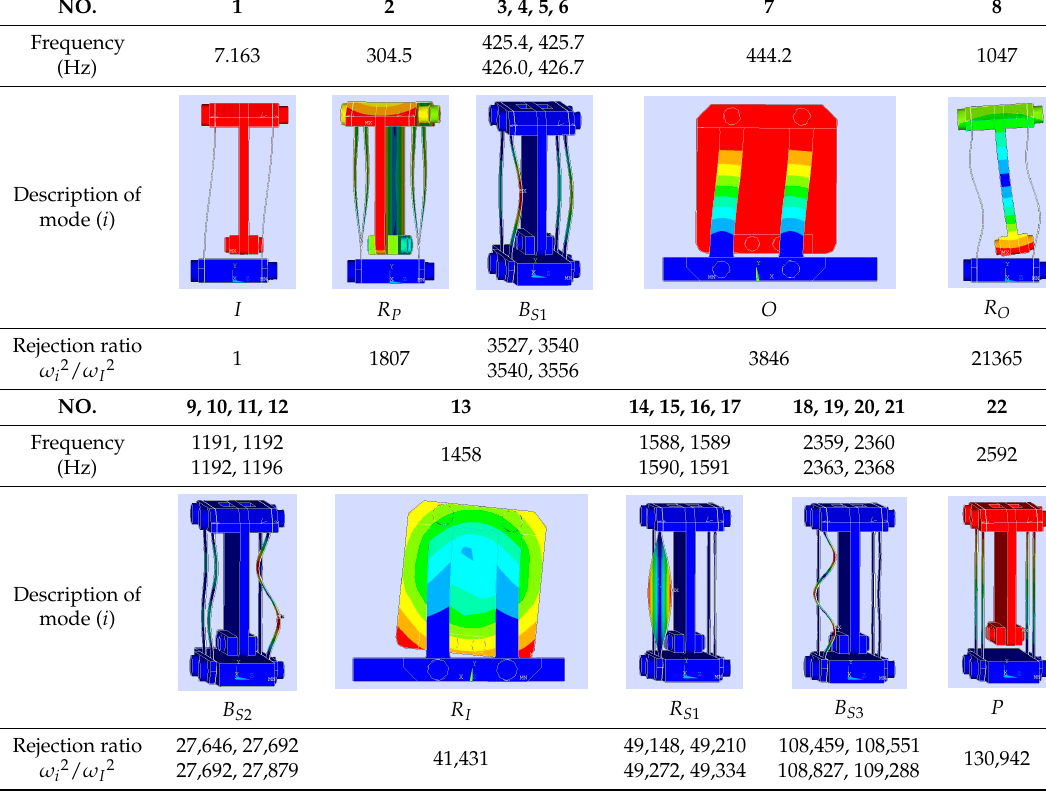
Table 2. The 22 lowest oscillation modes of the proposed spring-mass structure.